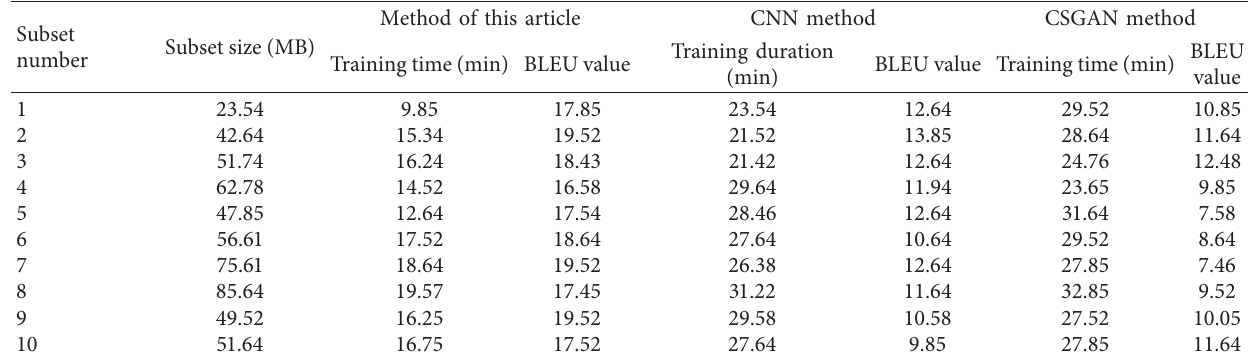
Figure 3: Comparison of training errors of different methods. Table 2: Comparison of translation